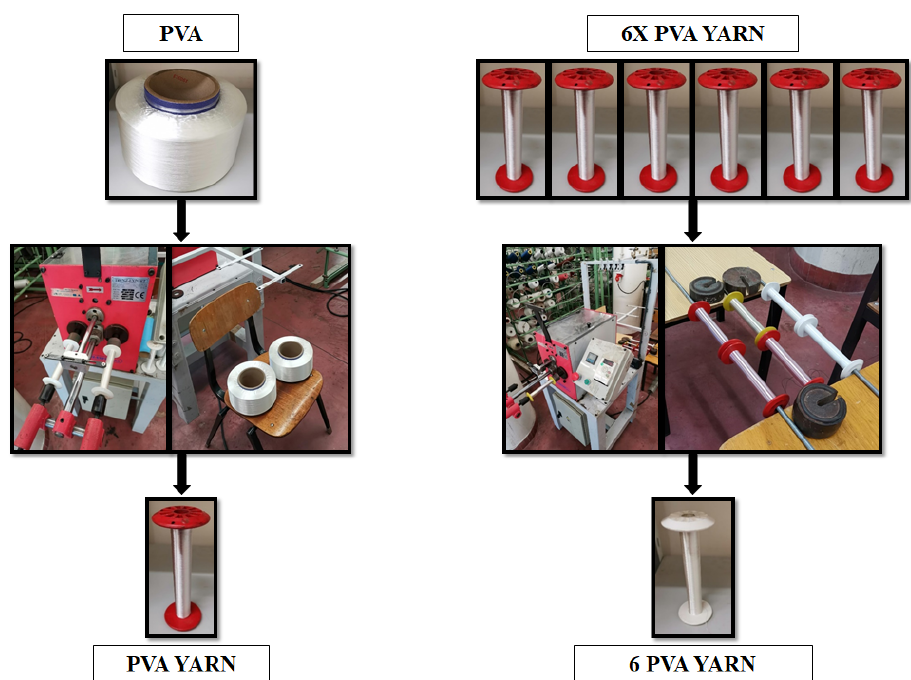
Figure 1. Production process of 6 PVA yarn. Three types of braided yarns (6, 8, and 10) were formed from 6 PVA yarn (Figure 1). This process was executed in a TRENZ-EXPORT ® (Barcelona, Spain) vertical braiding machine, model 16/100, serial number 00/2295. Figure 2 shows the braiding